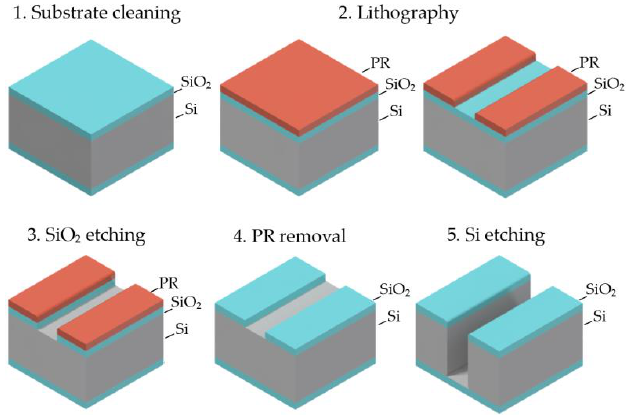
Figure 3. The sequence of operations for creating trenches in silicon.